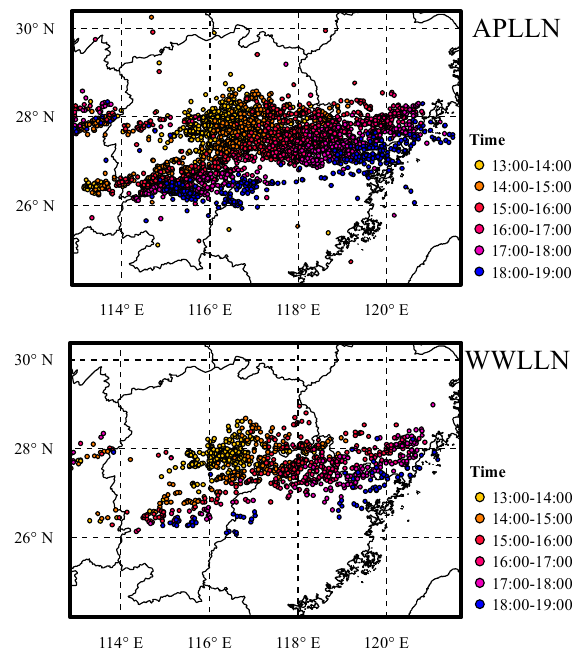
Figure 16. A thunderstorm occurred in southeast China. The figure shows the lightning location results of APLLN and World Wide Lightning Location Network (WWLLN), respectively. Each scatters represents a detected lightning stroke, with different colors indicating when the lightning occurred.